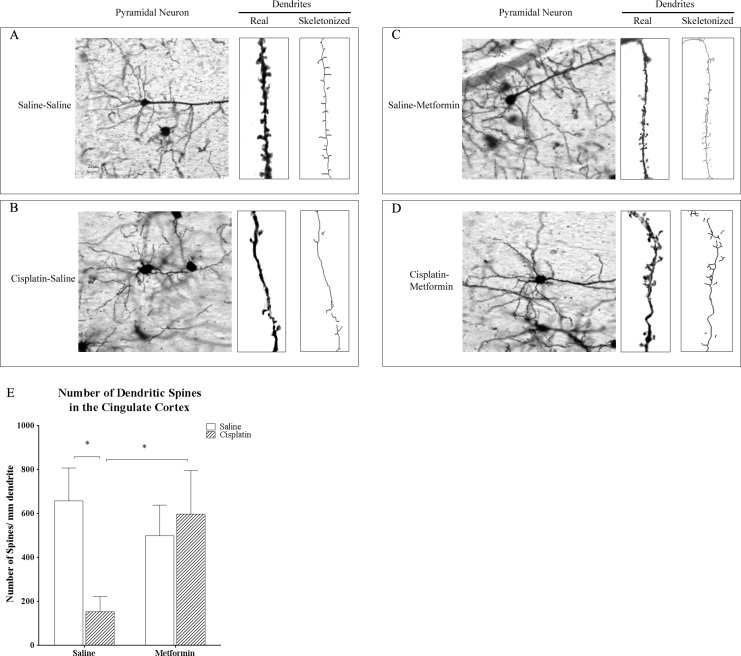
Effect of cisplatin and metformin on dendritic spine density Brains of mice treated with cisplatin and metformin were stained using a Golgi-staining kit and sliced were analyzed for dendritic spine density on pyramidal neurons in the cingulate cortex.(A-D) representative examples of actual images, an actual dendrite and a skeletonized dendrite. (E) Quantified data were analyzed by two-way ANOVA (cisplatin×metformin, F(1,17) = 22.26, p<0.05) followed by Tukey. Scale bar: 20μm. All data are expressed as mean±SEM. *, p<0.05. n = 5–6 per group